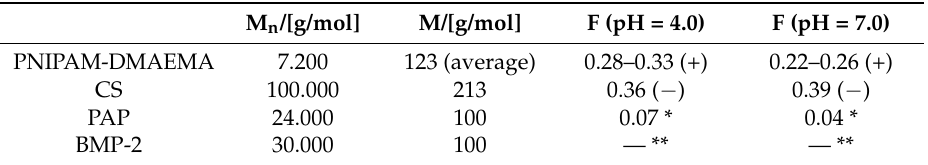
Figure 1. Formulae of PNIPAM-DMAEMA ( a ), CS ( b ), BMP-2 ( c ) and papain ( d ). Table 1. Polymer (M n ) and monomer (M) unit molecular weights and charge factors F of PNIPAM-DMAEMA, CS, PAP and BMP-2 at pH = 4.0 and pH = 7.0. ( − ) and (+) denote charge